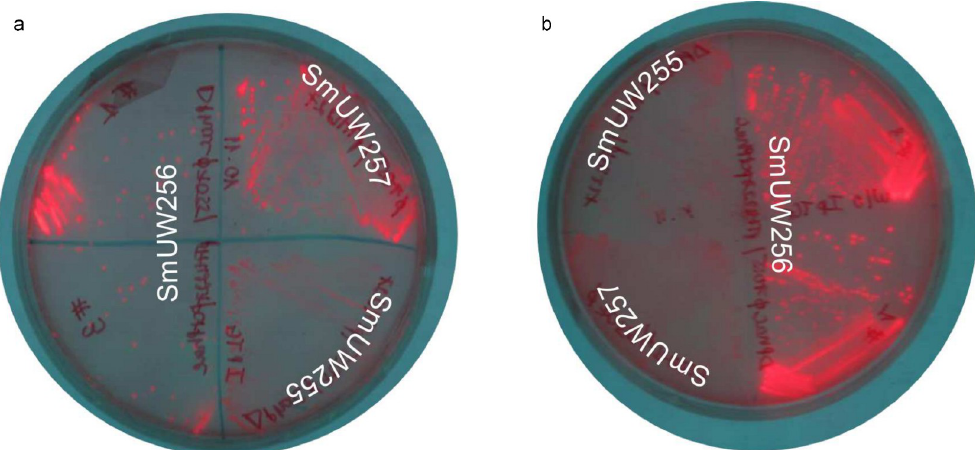
Fig 2. Phenotypic complementation of plasmid-based S . meliloti strains. a and b demonstrate phenotype difference between plasmid-engineered S . meliloti strains and other S . meliloti strains: SmUW255 ( Δ phbC exoF ::Tn5 harboring empty plasmid pTH1227), SmUW256 ( Δ phbC exoF ::Tn5 harboring pTAM (#1, 3)), SmUW257 ( exoF ::Tn5 harboring pTH1227). a: induced condition, b: non-induced